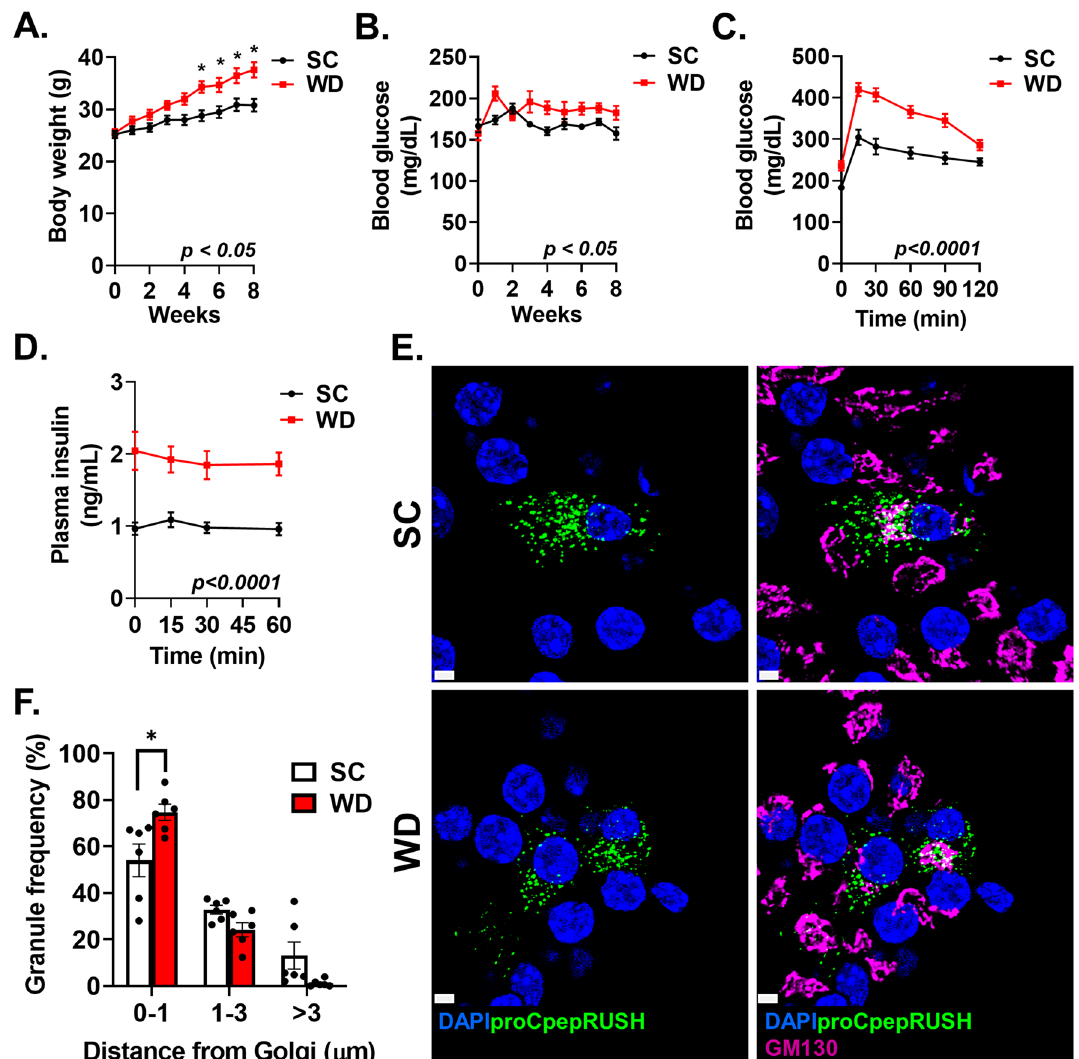
Figure 4. Impaired insulin granule formation in a diet-induced model of islet dysfunction. 8–10 week old male C57BL6/J mice were maintained on standard chow (SC) or Western diet (WD; 40% fat/kcal, 43% carbohydrate) for 8 weeks. Body weight ( A ) and ad lib fed blood glucose ( B ) were measured weekly (n = 10 mice per group). ( C-D ) Following 8 weeks of diet, 4–6 h fasted mice (n = 14–15 mice per group) were injected i.p. with glucose (1 mg/g bw). Blood glucose ( C ) and plasma insulin ( D ) were measured at the indicated times. ( E – F ) Isolated mouse islets were treated with AdRIP-proCpepRUSH (n = 6 mice per group; 3–21 cells per mouse). 48 h post-infection, islets were incubated with biotin (200 μM) for 3 h at 37 °C to stimulate proCpepRUSH (green) trafficking. Cells were immunostained for GM130 (magenta) and counterstained with DAPI (blue). ( E ) Representative images are shown. Scale bar = 5 μm. ( F ) The distances of proCpepGFP-positive granules from the Golgi were normalized per cell as a frequency distribution. Data represents the mean ± S.E.M. * p < 0.05 by 2 way-ANOVA with repeated measures ( A - D ) or Sidak post-test analysis ( F